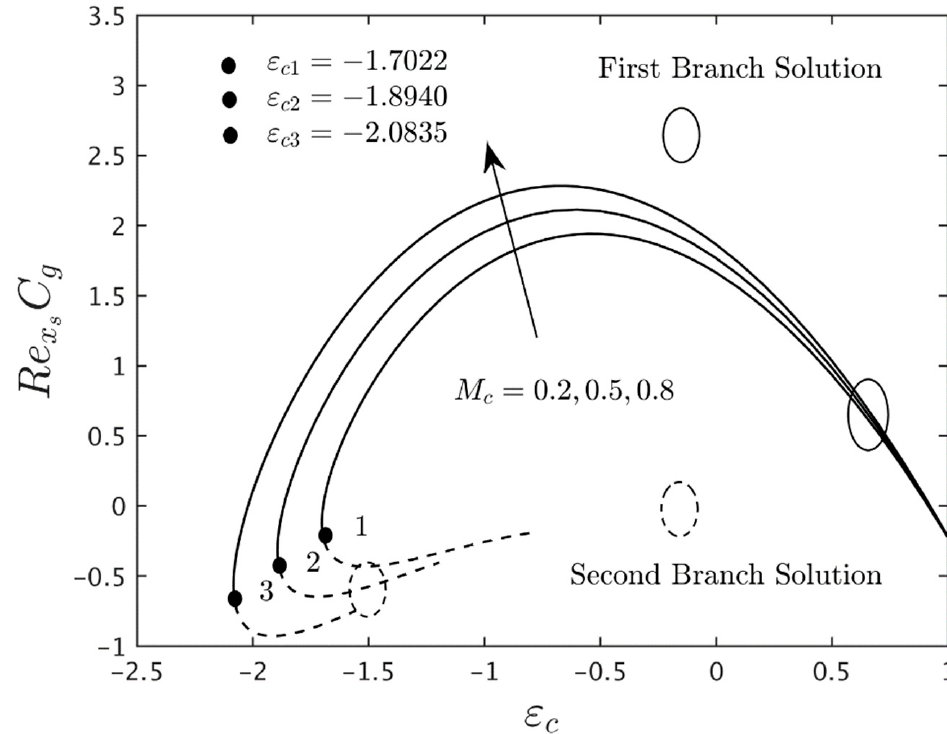
Figure 6. Variation of the CSC with ε c for the several values of M c .